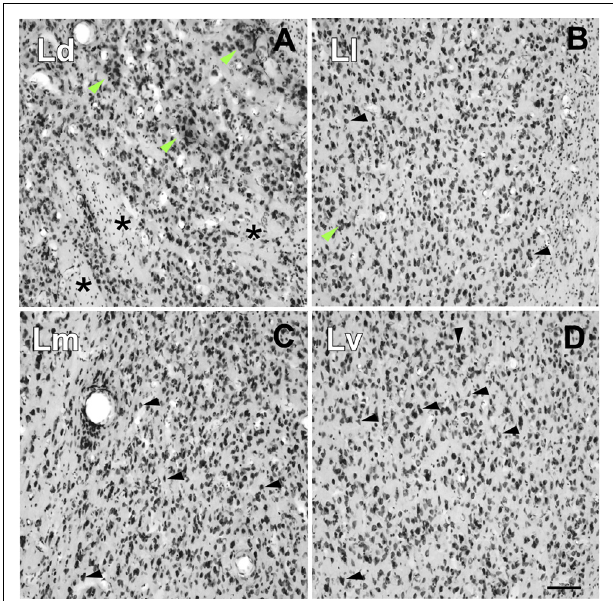
FIGURE 6 | High-power photomicrographs showing the cytoarchitecture of the lateral nucleus subdivisions. (A) Ld neurons are medium to large sized and clustered (green arrows). Asterisks indicate accumulations of small areas of white matter. (B) Neurons in the Ll have different shapes (black arrows) and are less densely packed than in the Ld (A) and Lm (C) , and more densely than in the Lv (D) ; neuron clusters are rare (green arrow). (C) Neurons in the Lm have a variety of shapes and sizes (black arrows). (D) The Lv is characterized by a relatively low neuronal density with great variability in their sizes and shapes and poorly stained. Scale bar: 100 µ